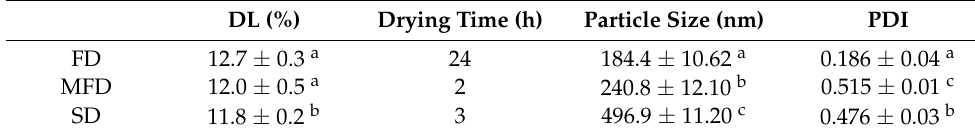
Table 1. Characteristics of the UA-loaded chitosan nanoparticles. DL (%) Drying Time (h)